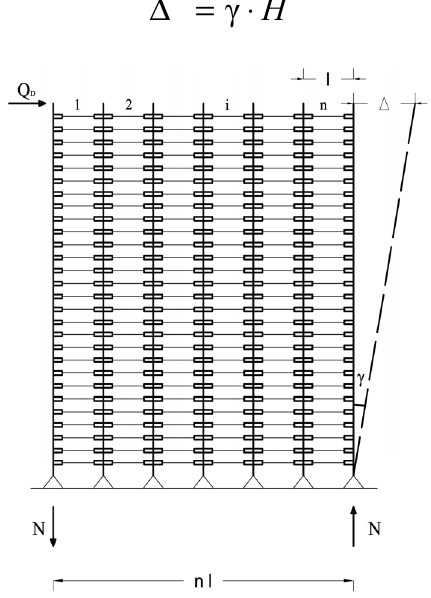
Figure 13. Multi-bay dissipative